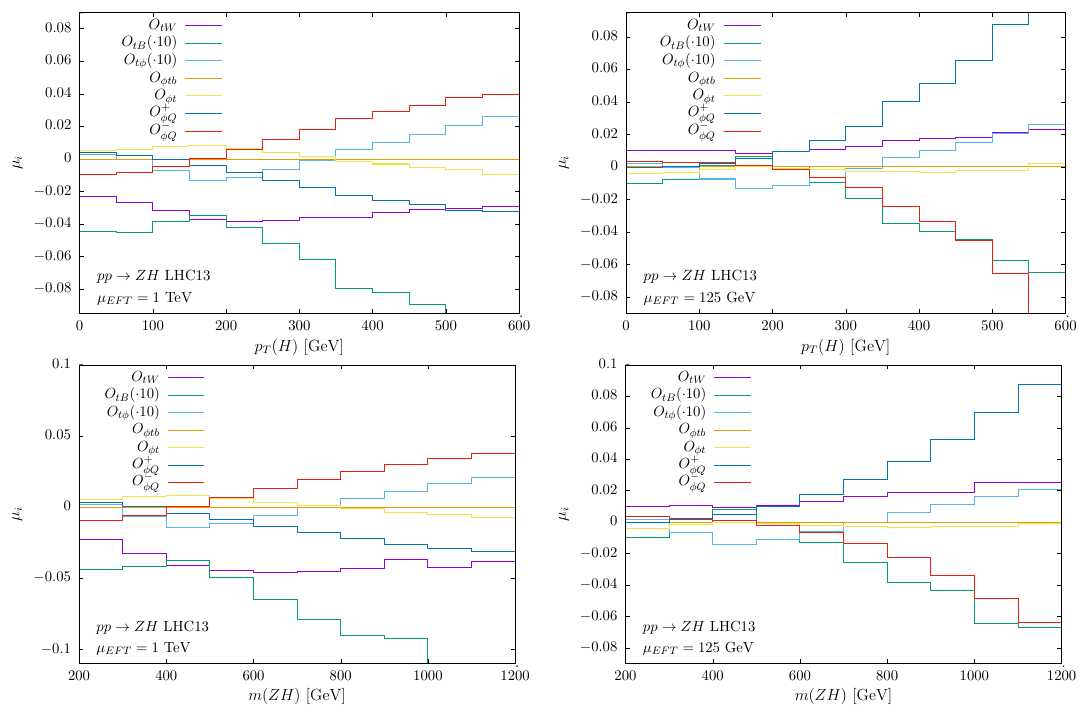
Figure 4 . Sensitivity of the Higgs transverse momentum distribution (top) and ZH invariant mass distribution (bottom) in ZH production for the di(cid:11)erent operators at (cid:22) EFT = 1000 GeV (left) and (cid:22) EFT = 125 GeV